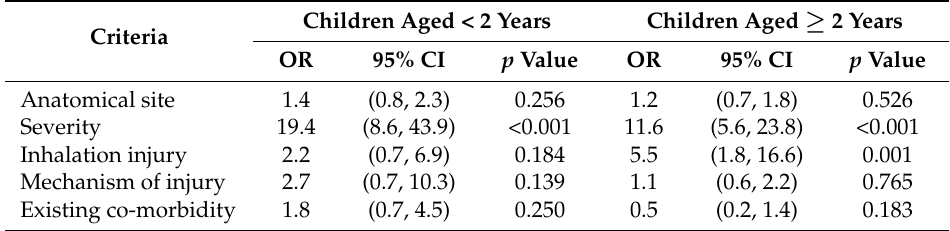
Table 5. Association between single referral criteria and burden of having to undergo surgery or stay longer than seven days at the centre by age category of the